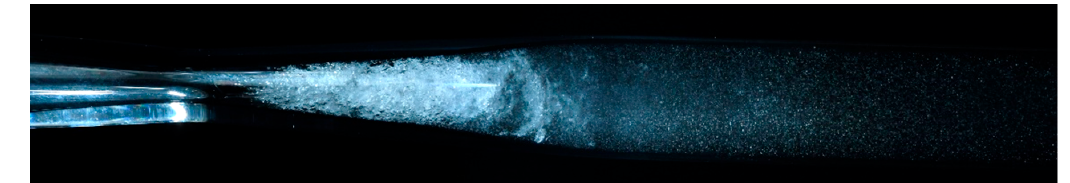
Figure 16. Aspects of vortex cavitation in the Venturi tube observed with a flash lamp. A pressure wave, which is indicated by the white arrow, was observed by collapsing residual bubbles.